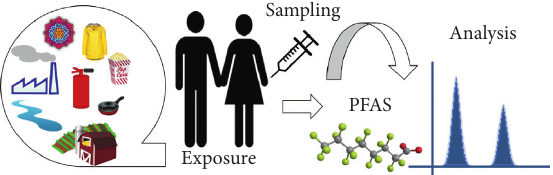
Figure 1: Assessment of human exposure to PFAS through biomonitoring.